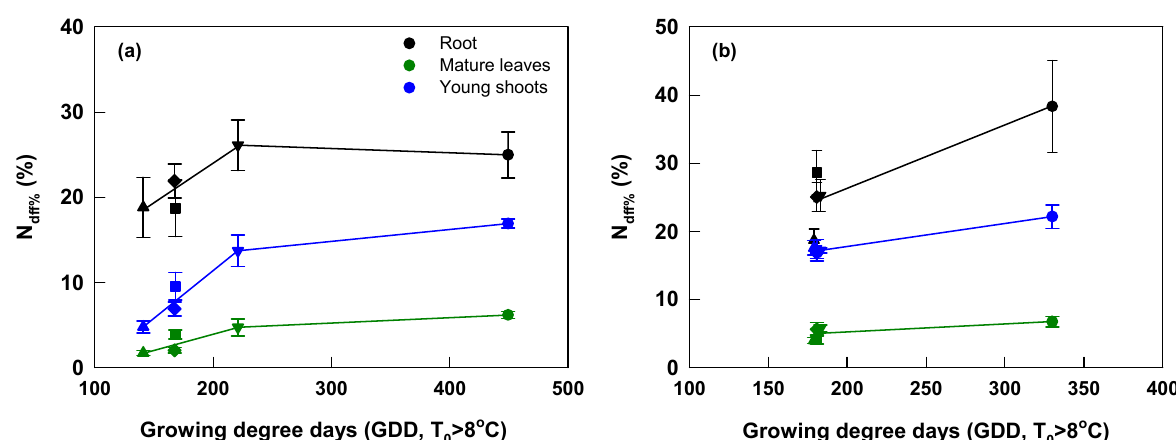
Figure 6. Relationship of N dff% of root, mature leaves, and young shoots on the day of the first harvest (DFH) with growing degree days (T > 8 °C, GDD) between fertilization dates and DFH at Yongchuan ( a ) and Xingyang ( b ). Black, green and blue colors of symbols and lines indicate root, mature leaves, and young shoots, respectively. Symbols ○ , ▽ , □ , ◇ , and (cid:4574) indicate fertilization dates in October, November, December, January, and February, respectively.